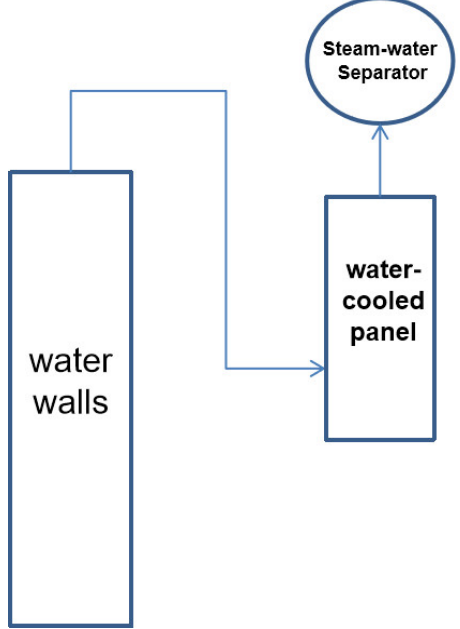
Figure 2. Secondary rise water cooling wall